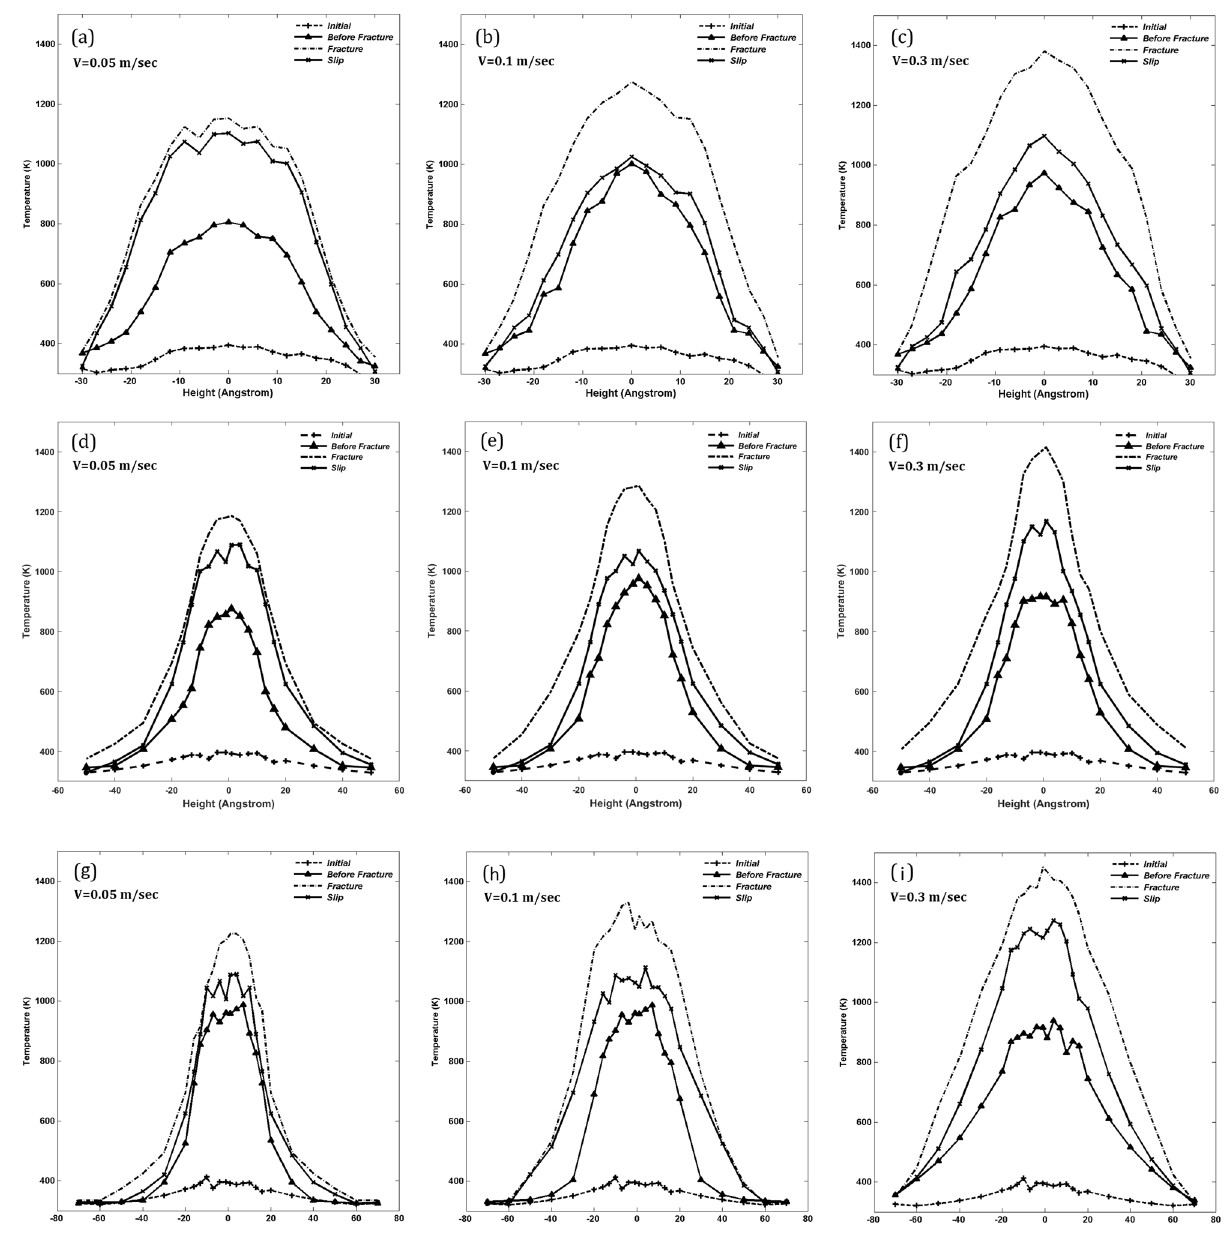
Figure 6. Temperature profile across the amorphous region in the three Structure, A, B, and C, immediately before, at, and after flash heating events for several velocities, and their comparison with the initial